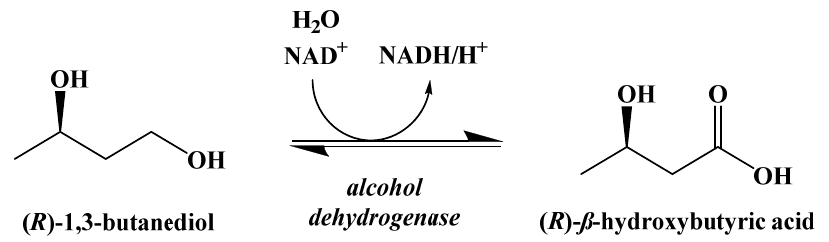
shown to generate ketone bodies through an unknown pathway [93].